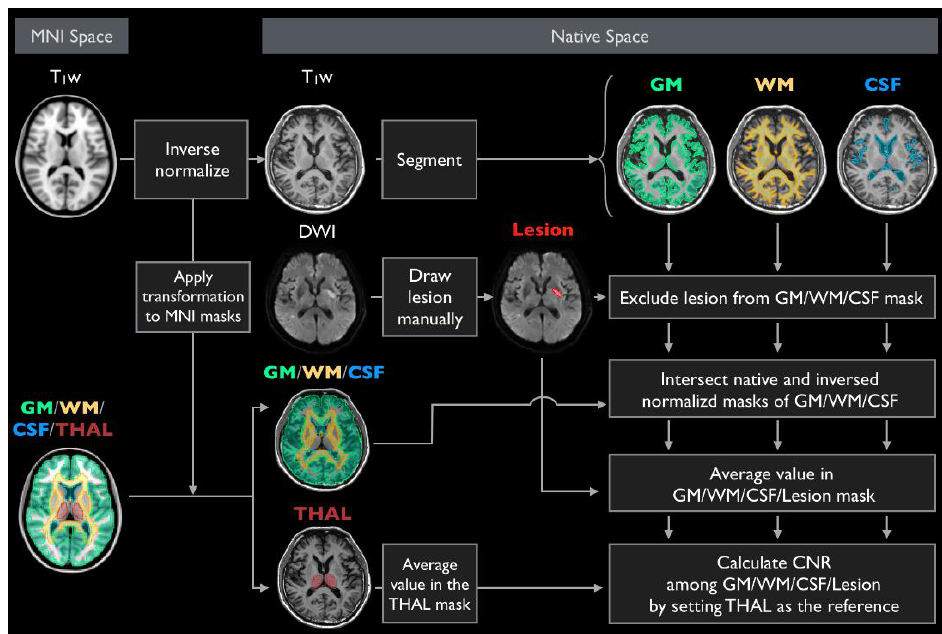
Figure 2. Data processing flowchart for quantitative tissue contrast validating synthetic scans.